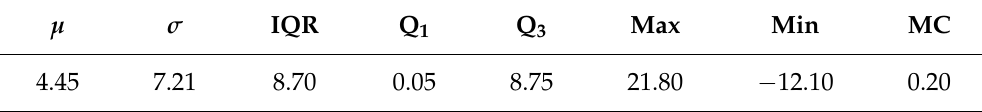
Table 5. Statistical summary for tests performed using